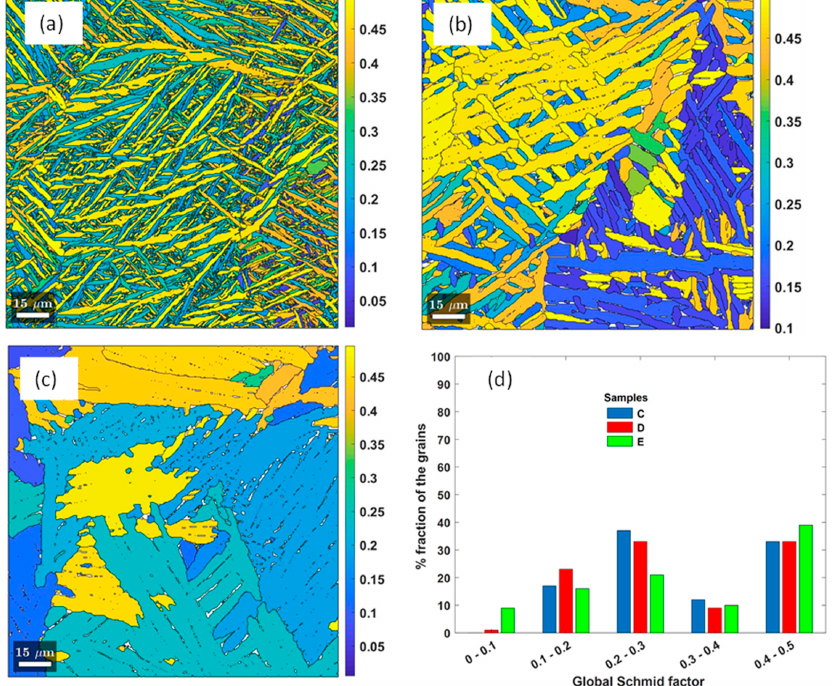
Figure 9. Typical values of the global Schmid factor for prismatic slip systems of the α -phase for the load applied along the build orientation in samples ( a ) C, ( b ) D and ( c ) E, while ( d ) shows the statistical distribution of the values obtained in each form of material.